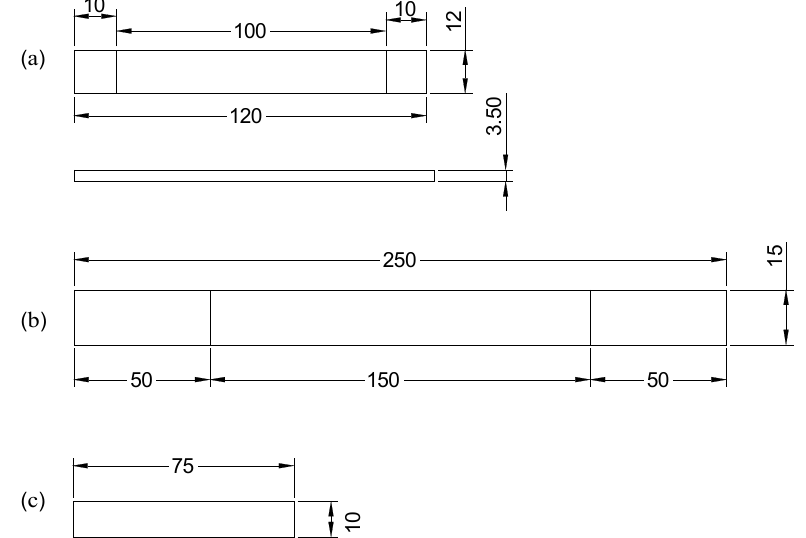
Figure 2. ( a ) Standard three ‐ point flexural specimen as per ASTM D7264. ( b ) Standard tensile specimen following ASTM D3039 recommendation. ( c ) Standard Charpy impact specimen according to ASTM D6110 recommendation.